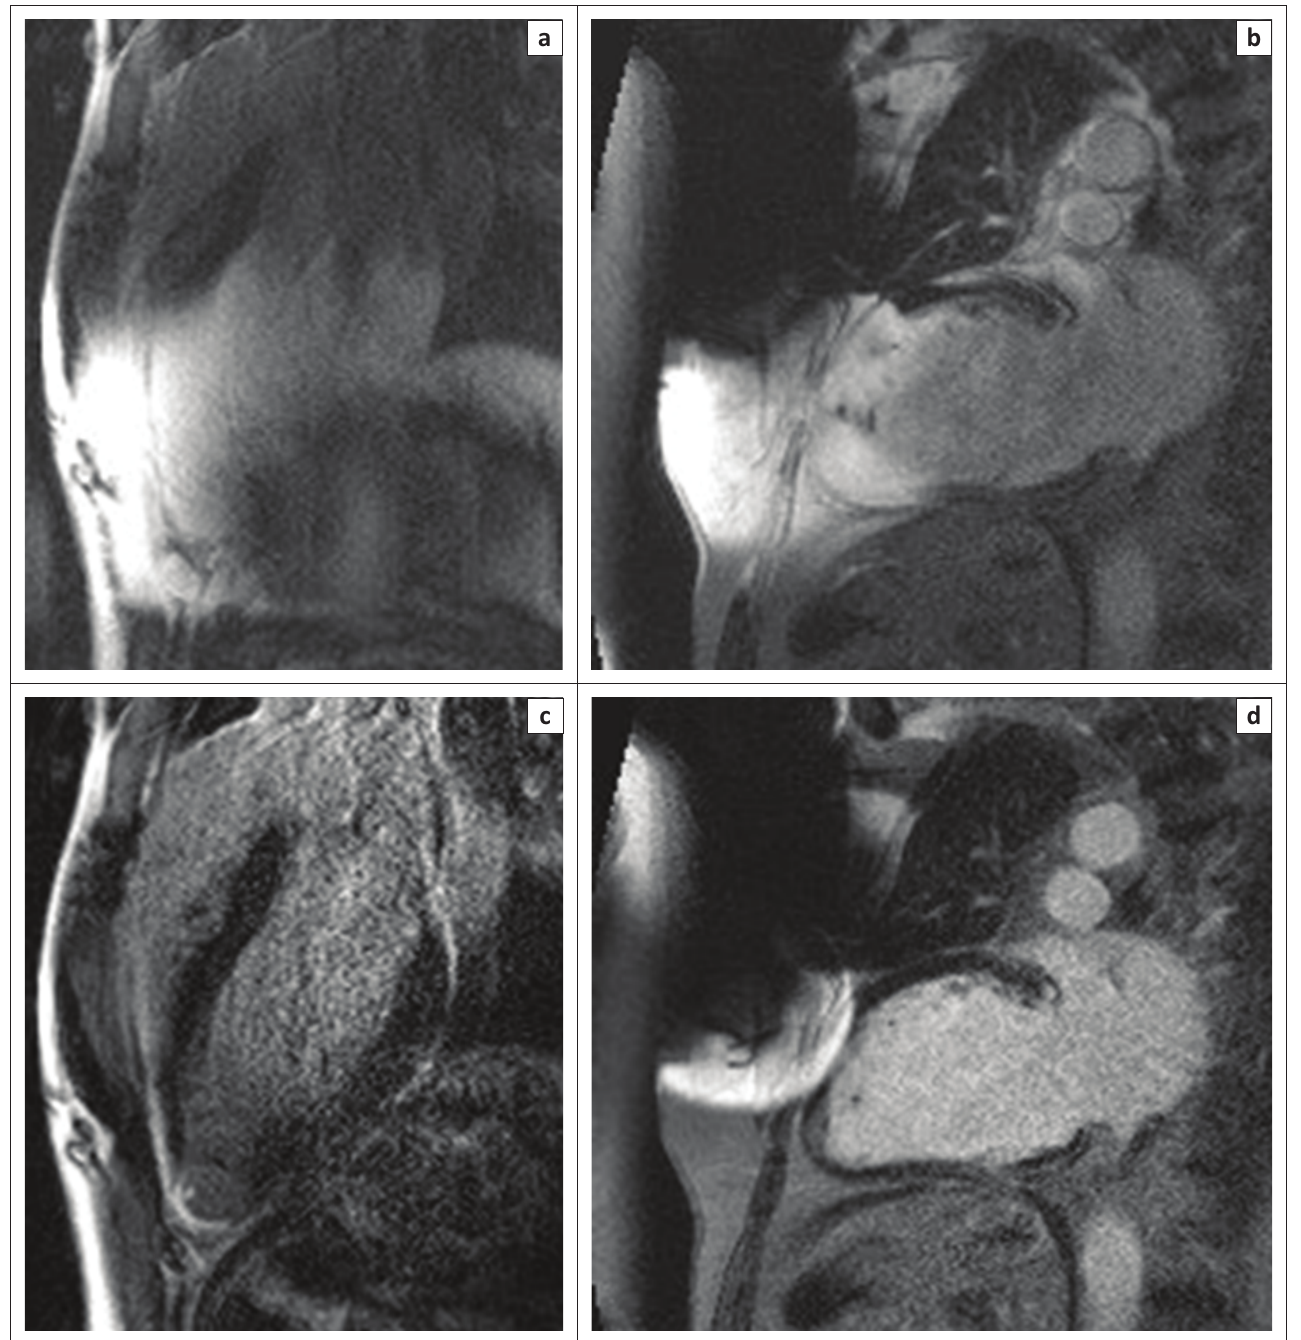
FIGURE 4: Three-chamber (a and c) and two-chamber (b and d) LGE images. A modified wideband LGE sequence (c and d) reduces artifact from the generator compared with standard LGE sequence (a and